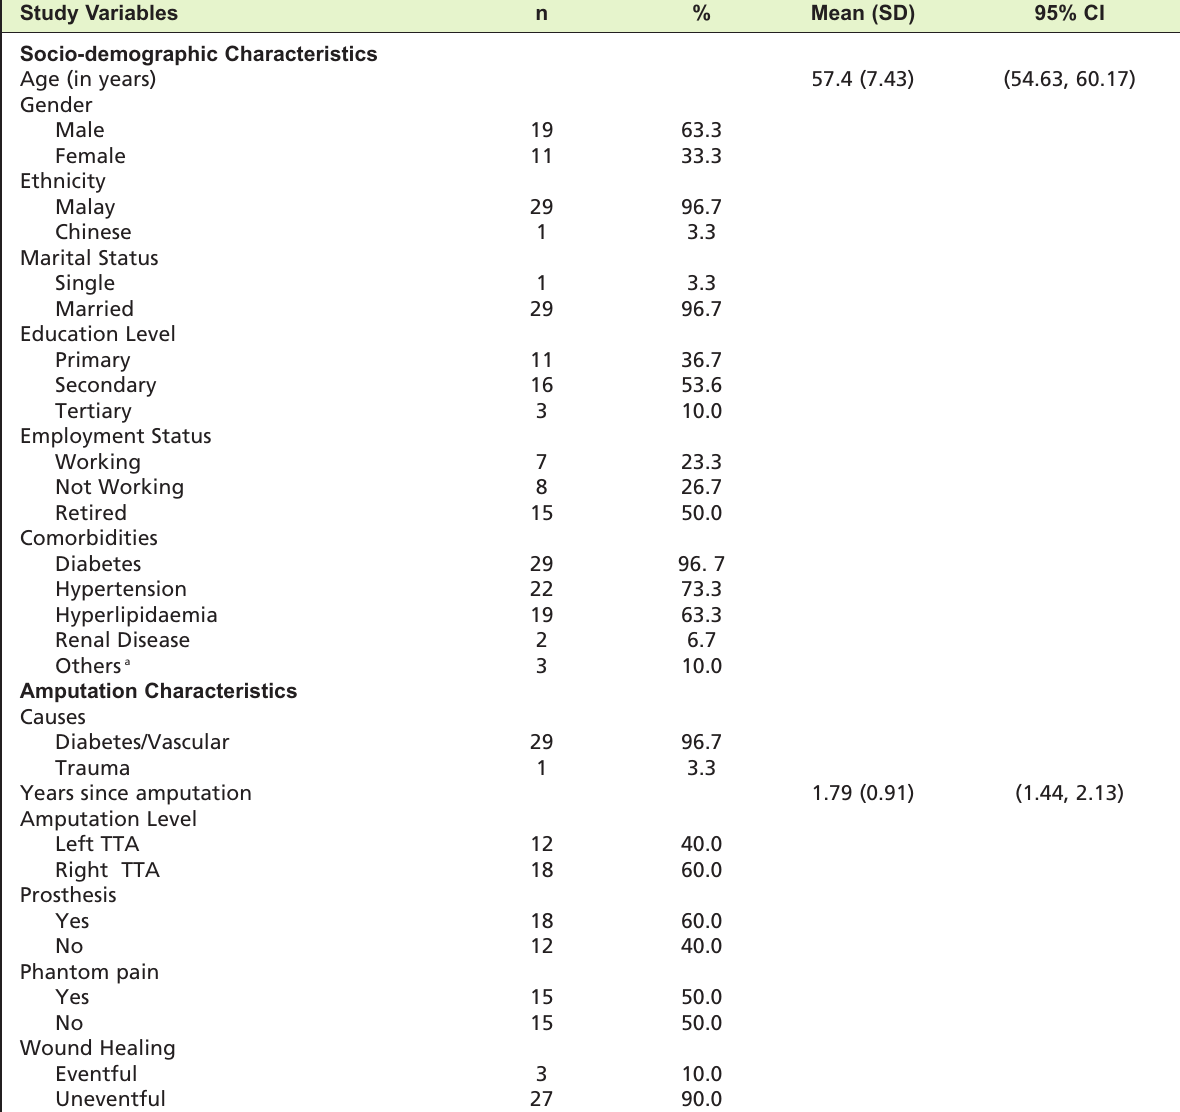
Socio-demographic and amputation characteristics of TTA participants Table I: